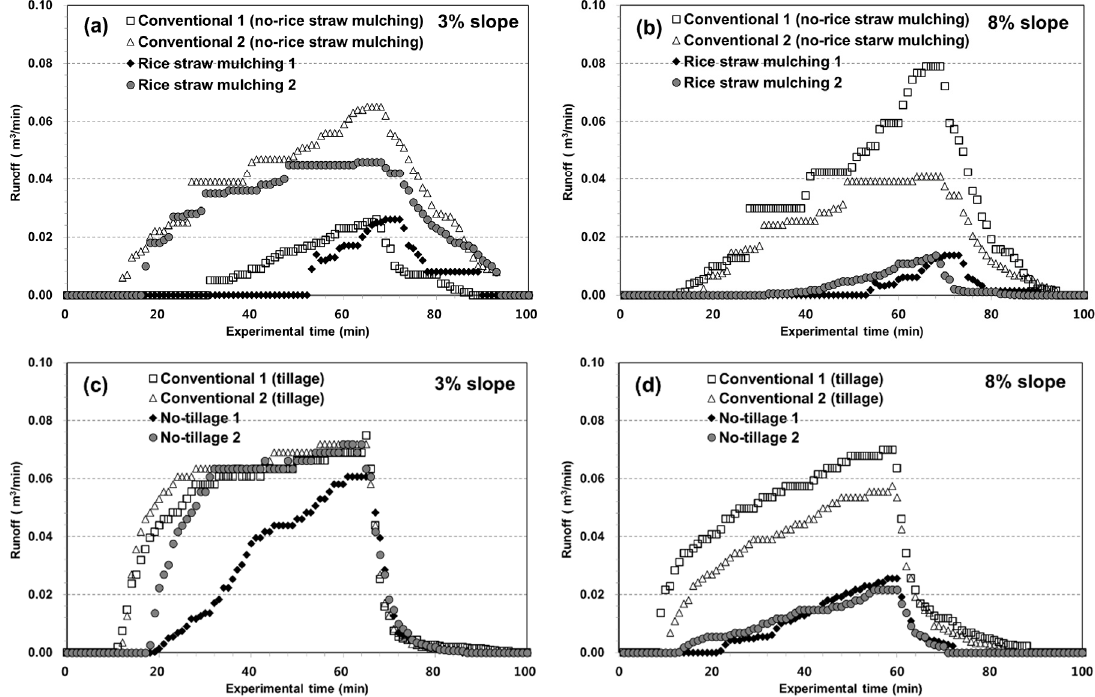
Figure 5. Field experiment results for runoff under the ( a ) rice straw mulching at 3% slope plot; ( b ) rice straw mulching at 8% slope plot; ( c ) no-tillage conditions at 3% slope plot; and ( d ) no-tillage conditions at 8% slope plot.